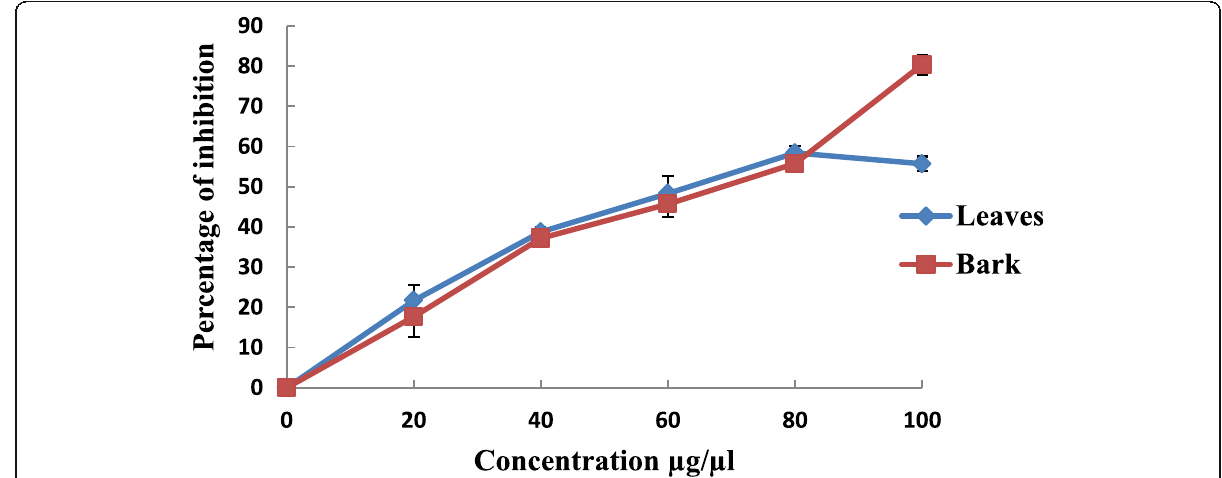
Fig. 10 Hydroxyl radical scavenging activity of S . palghatense leaves and bark. Error bars represent the standard error of observed data in all six